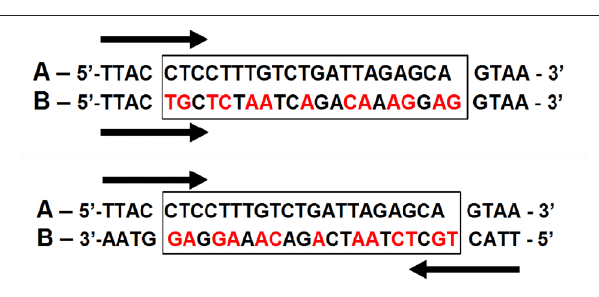
FIGURE 5 | The 13 base-pair inversion identified in the psbJ-petA sequence in 76 of 126 plants of Bactris gasipaes . Upper pair: A – ancestral sequence without inversion found in B. simplicifrons , B. riparia and half the plants of B. gasipaes var. chichagui type 1; B – inverted sequence with unaligned base-pairs in red. Lower pair: A – ancestral sequence; B – reinverted sequence to show original